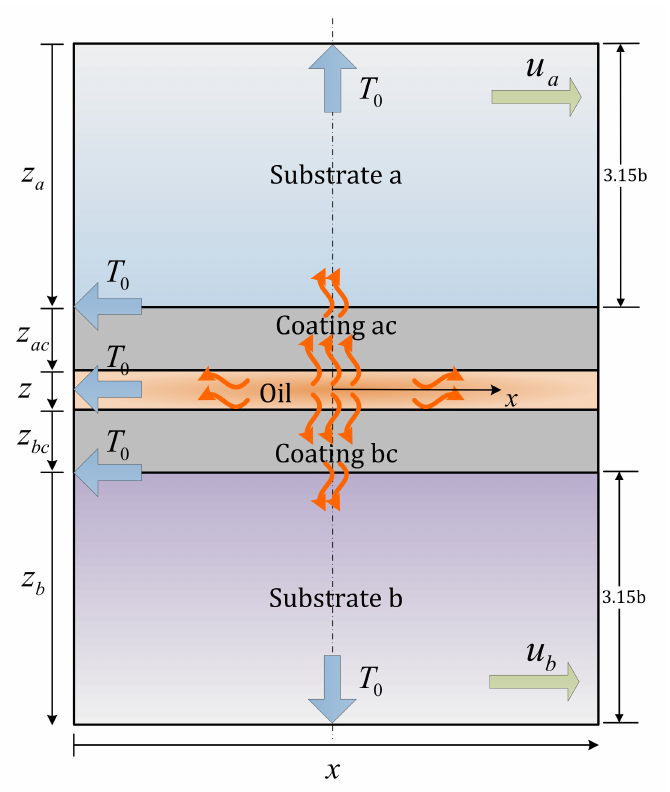
Figure 6. Schematics of the thermal model for the cam / tappet